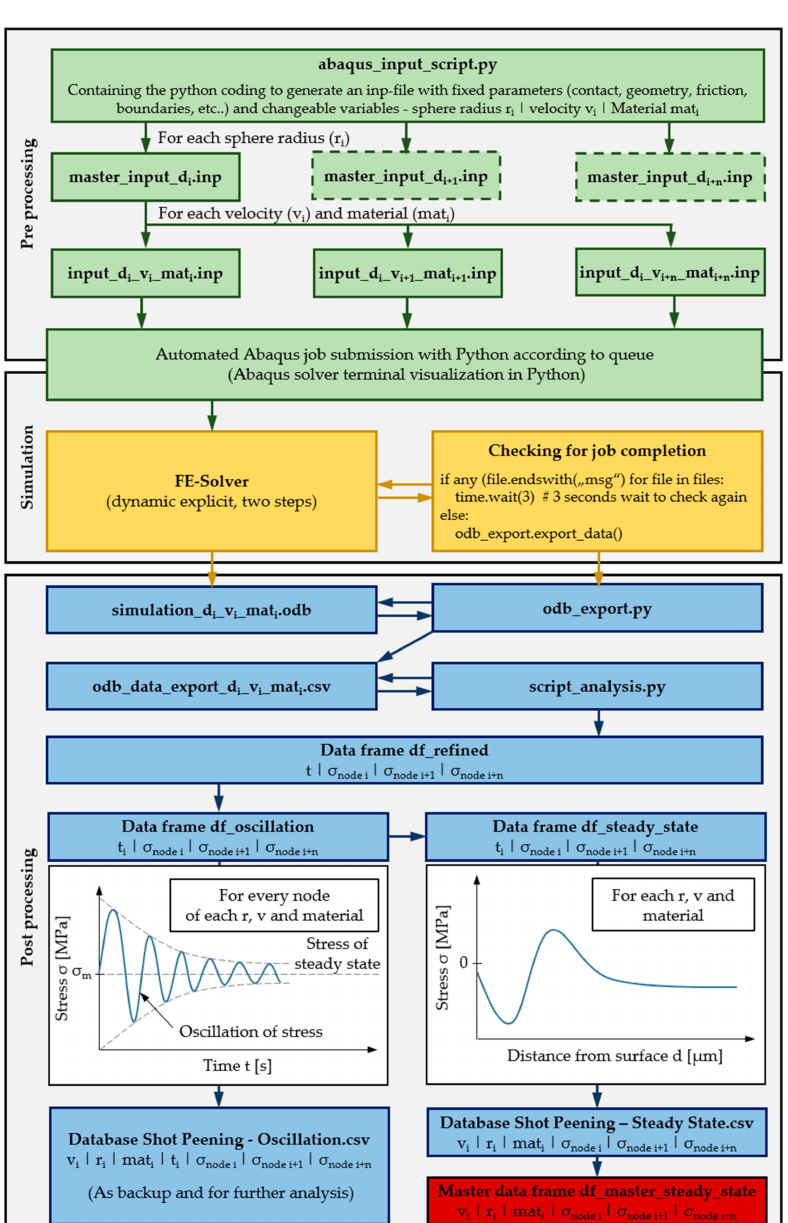
Figure 5. Programming logic for the obtainment of the database and master data frame from FEA